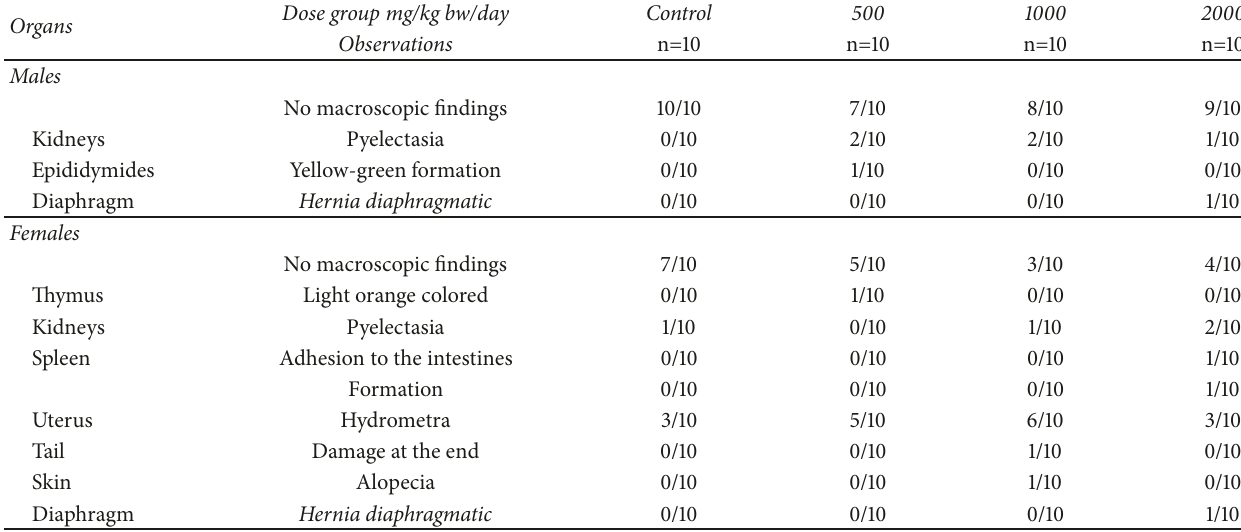
Table 7: Summary of macroscopic observations ∗ .